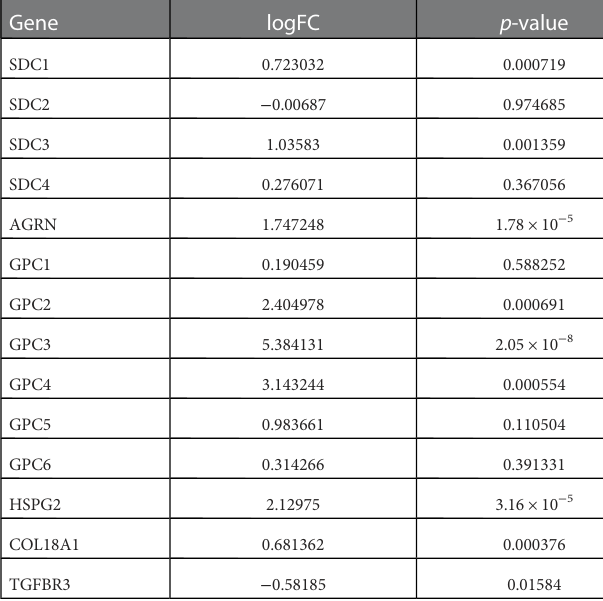
TABLE 1 Logfc and p -value of heparan sulfate